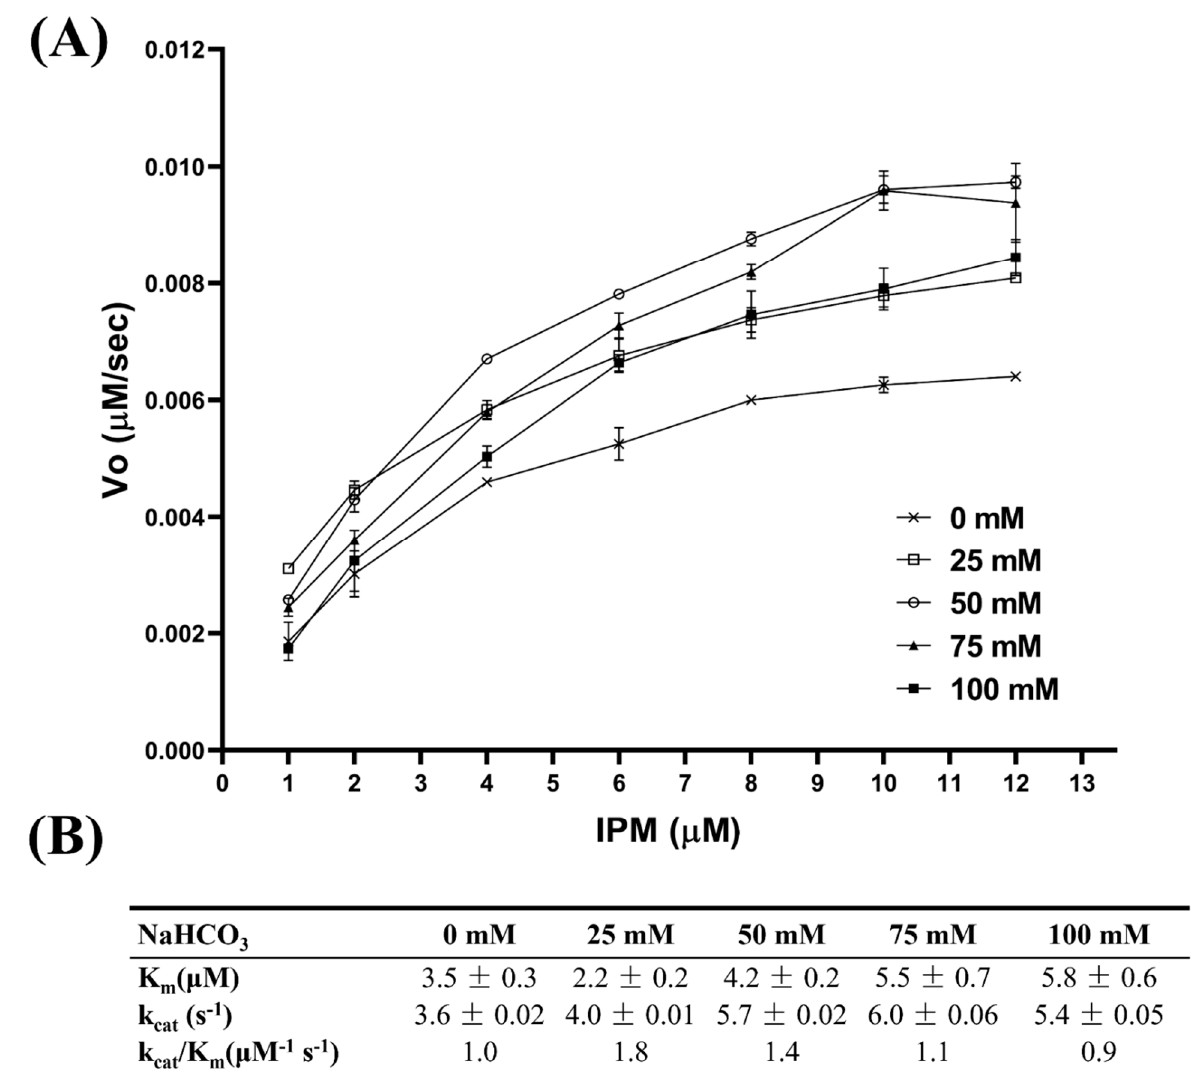
Figure 1. Effect of NaHCO 3 on the initial rate ( A ) and kinetic parameters ( B ) of OXA − 48 on imipenem (IPM) hydrolysis.